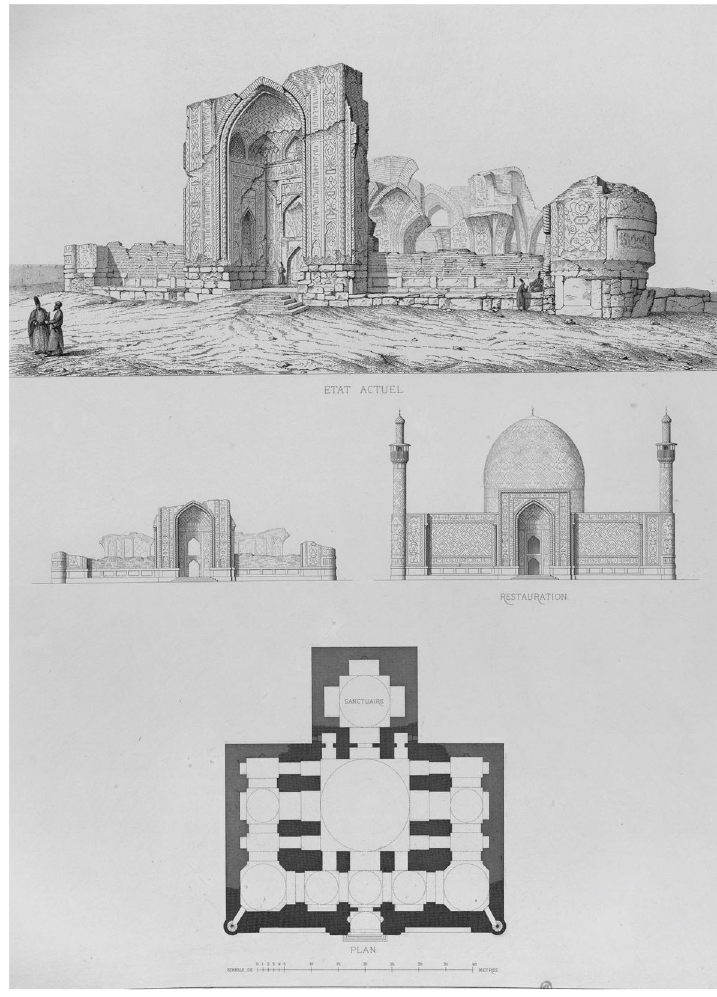
Fig. 3 Drawings of the ruined and restored states of the Blue Mosque in Tabriz (Source: Coste 1867,